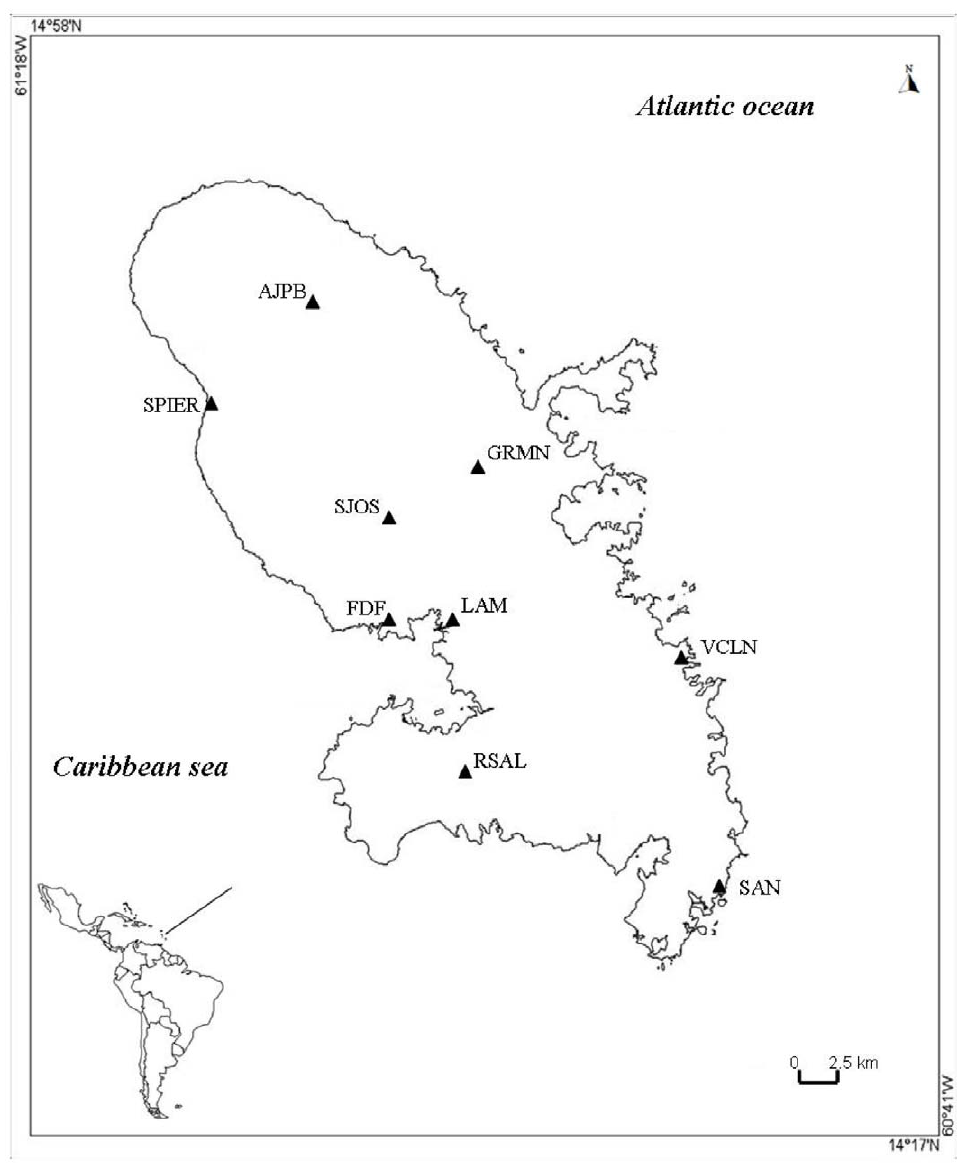
Figure 1. Location of Ae.aegypti populations sampling sites in Martinique. The samplings were made in the communities of Ajoupa- Bouillon, Saint Pierre, Gros Morne, Saint Joseph, Lamentin, Fort de France, Vauclin, Rivie`re Sale´e and Saint Anne respectively named AJPB, SPIER, GRMN, SJOS, LAM, FDF, VCLN, RSAL and SAN.